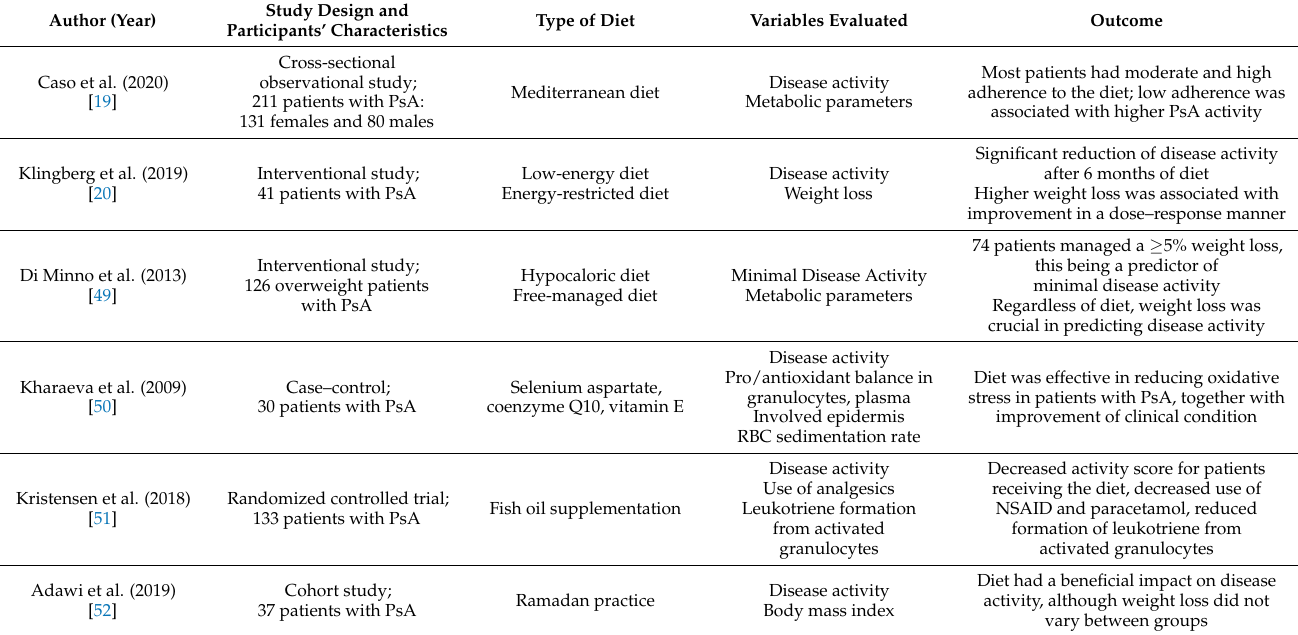
Table 2. Studies analysing the impact of different diets in patients with